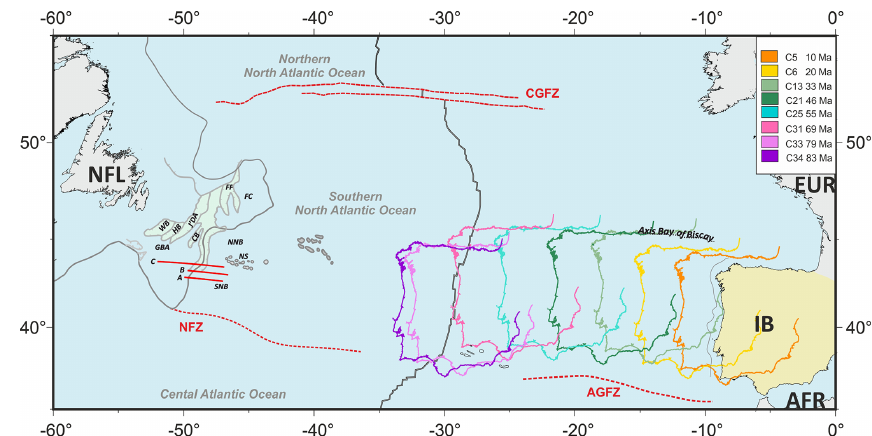
Figure 4. Map showing the positions of Iberia relative to North America from first unequivocal oceanic crust (83Ma), as modelled by Seton et al. (2012) for C3–C6, Srivastava et al. (1990) for C13–C31 and C34, and Macchiavelli et al. (2017) for C33. Numerical chron ages are Gradstein et al. (2012). Red lines show the position of seismic sections A–C, provided by TGS. CB – Carson Basin; FC – Flemish Cap; FP – Flemish Pass; GBA – Grand Banks; HB – Horseshoe Basin; NS – Newfoundland Seamounts; NNB – Northern Newfoundland Basin; SNB – Southern Newfoundland Basin; WB – Whale